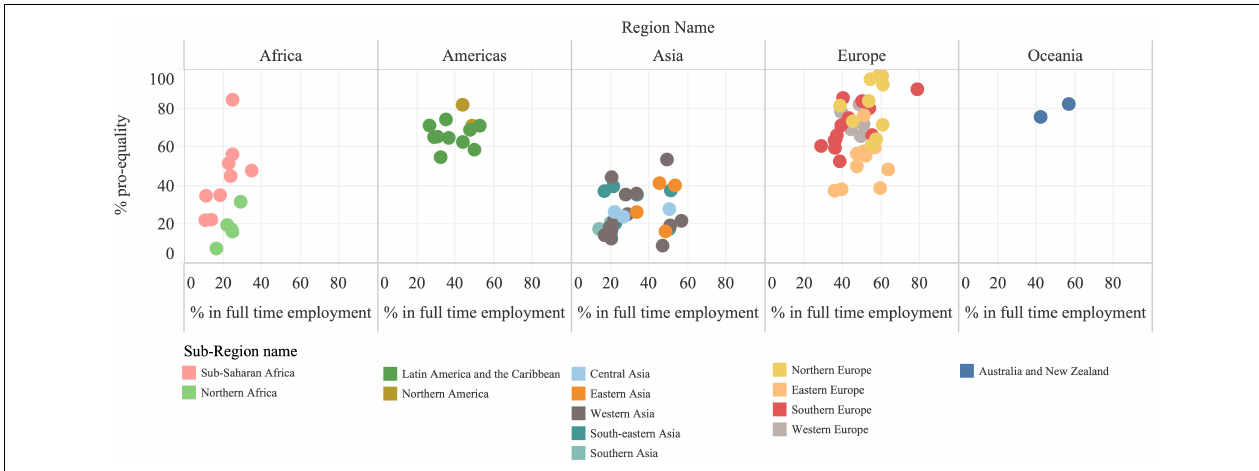
FIGURE 1 | Average pro-equality norms and full-time employment. Each dot represents a country. Countries are grouped by UN regions and colors indicate UN